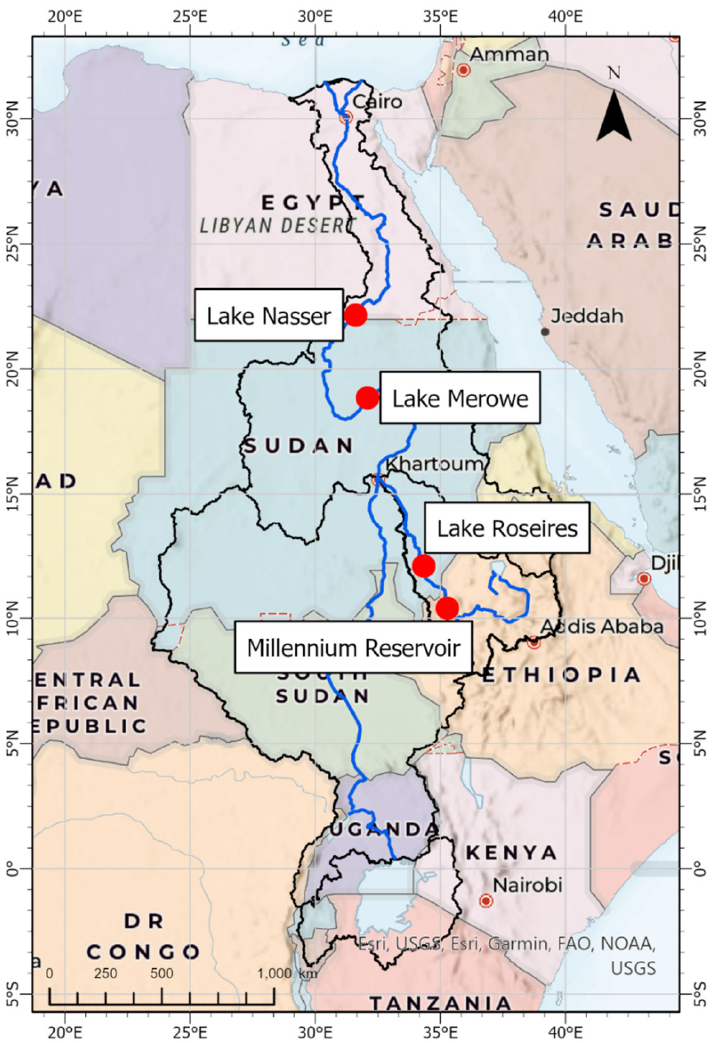
Figure 1. The Nile River basin and the reservoirs on the main channel of the Nile and the Blue Nile Rivers. The shapefiles for watershed boundaries and the river network were downloaded from the World Bank Data Catalog (https://datacatalog.worldbank.org/search/dataset/0042032, accessed on 12 April 2022).